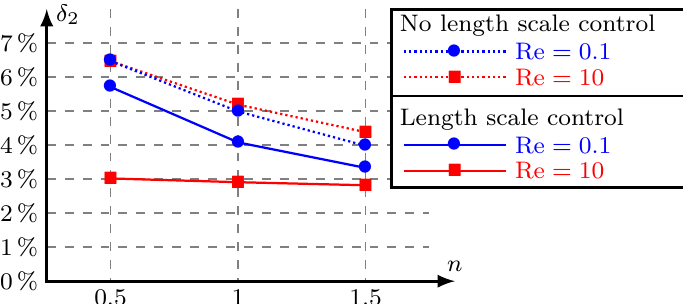
Figure 12. The difference δ 2 of four optimization results between 2D and 3D models with the ratio of depth to width of the inlet n